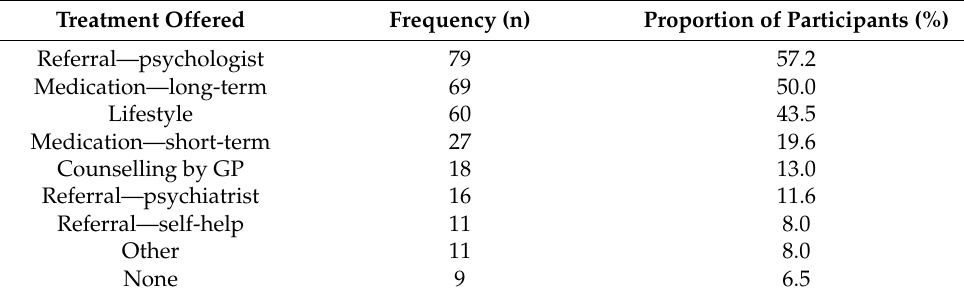
Table 4. Treatments offered by GP at first